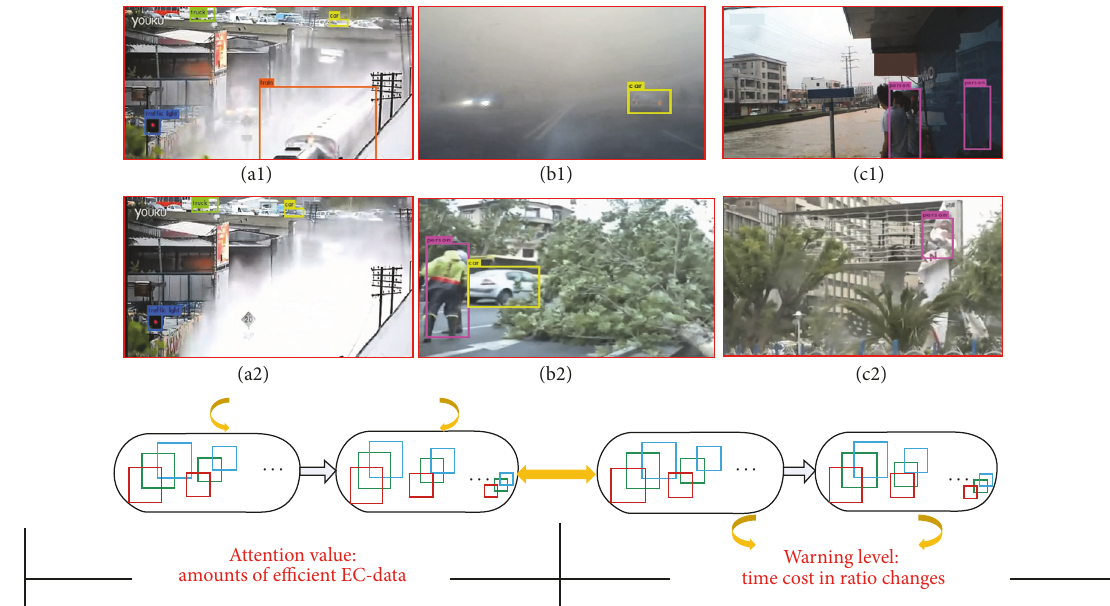
Figure 2: Unneglectable surrounding environment changes (EC) with various EC-implications in video recognition, objects vague (a1 and b1), occlusion (a2 and b2), or dummy (c1 and